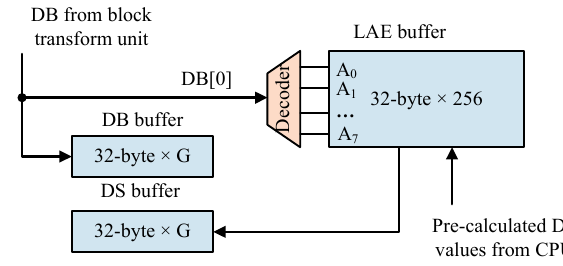
Figure 10: Schematic of the look-ahead execution technique.